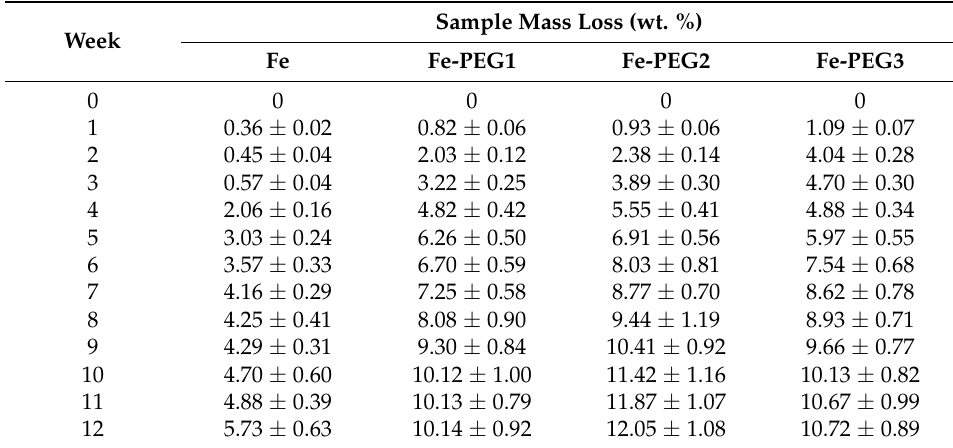
Table 3. The average values of mass losses of open cells iron samples after 12 weeks of static corrosion in Hanks’ solution.